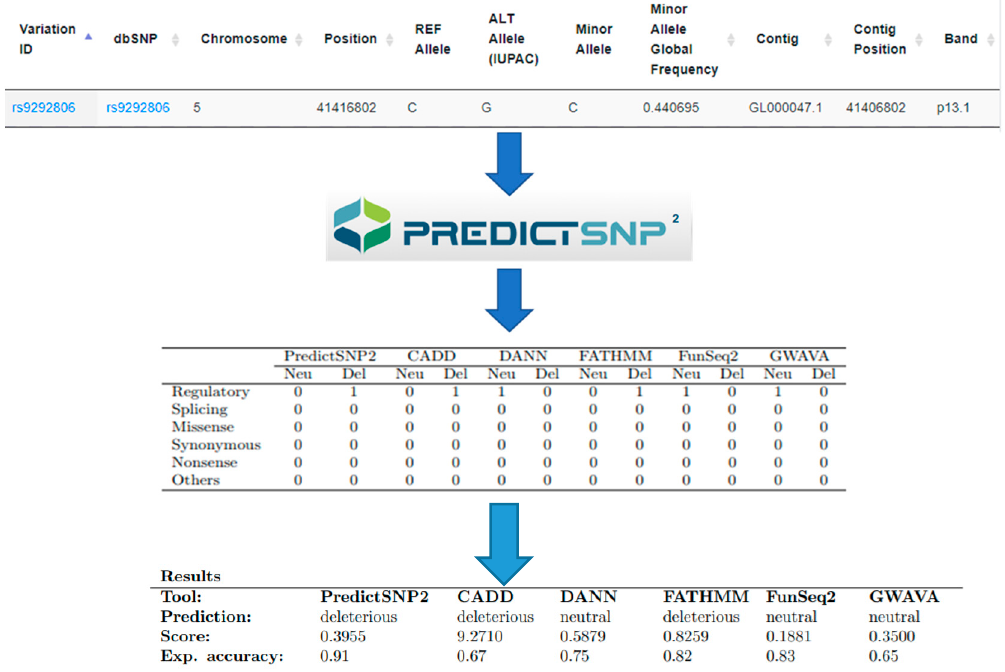
Figure 4. Prediction the effect of the rs9292806 of function and expression of PLCXD3 using the PredictSNP2 platform.